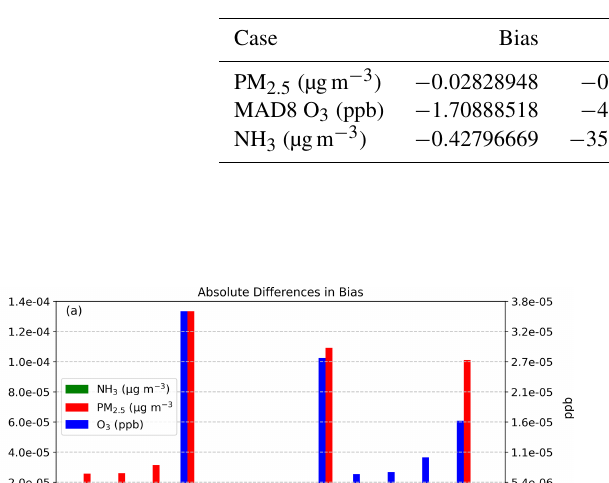
Table 3. Annual bulk statistical metrics for all grid–point pairs for the unaltered simulation (orig) binned by species (row) and statistic (column).